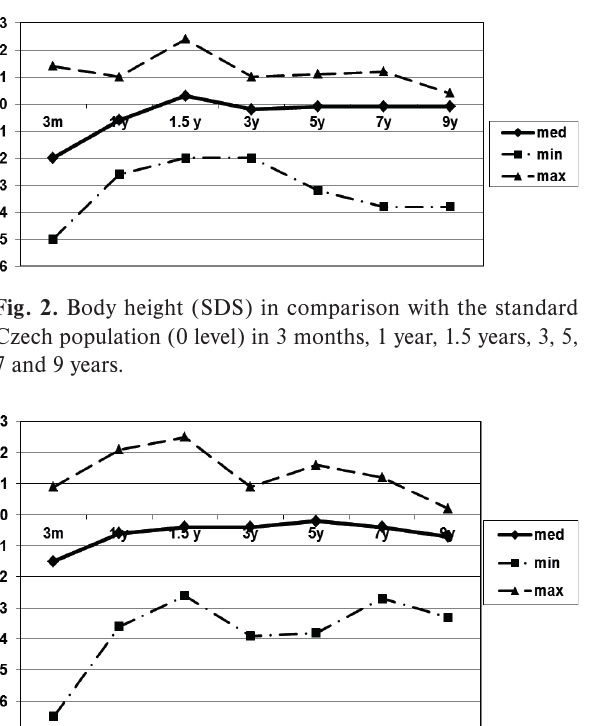
Fig.1. Body mass index (SDS) in comparison with the standard Czech population (0 level) in 3, 5, 7 and 9 years.